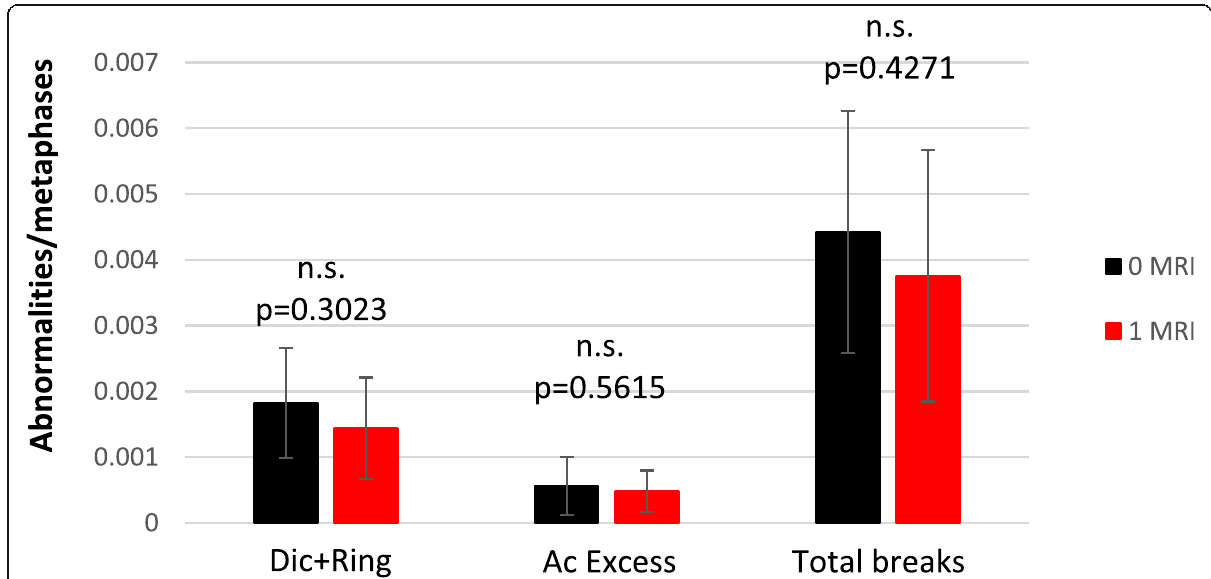
Fig. 1 One MRI session does not trigger any genotoxic effect. The dicentric chromosome assay was performed on blood cells of volunteers sampled 30, 15, and 0 days before the exam to take into account the heterogeneity of the background (mean in black). The potential effect of one MRI session was assessed the day of the first MRI and prior to the second MRI (mean in red). Unstable aberrations (Dic + Tric + ring) were scored after telomere and centromere staining, as well as acentric fragments (type E acentrics, acentrics in excess), those resulting from Dics or ring being excluded). Total breaks were calculated from these data. Ac , Acentric fragment; Dic , Dicentric chromosome; MRI , Magnetic resonance imaging; n.s. , No significant differences; Tric , Tricentric